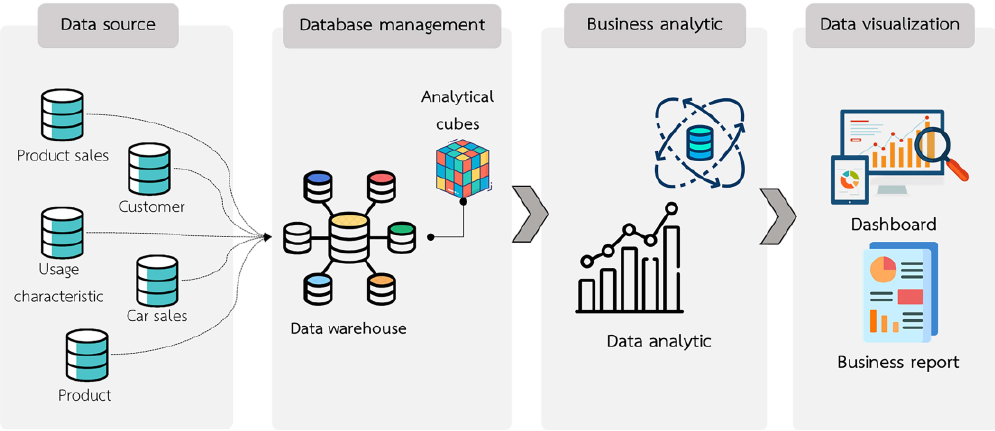
Figure 1. Business intelligence architecture.